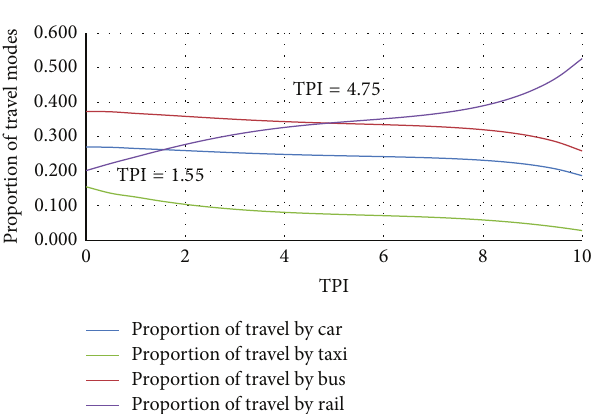
Figure 6: Changing trends of choice among four travel modes.